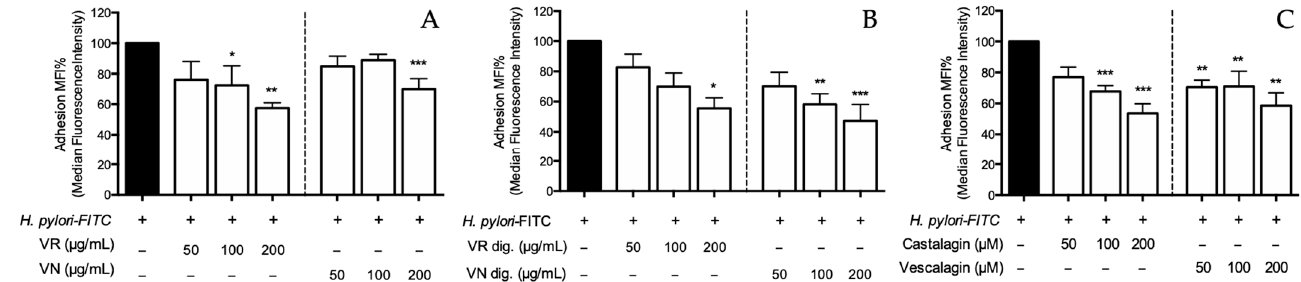
Figure 7. Effect of Castanea sativa Mill. leaf extracts and pure ellagitannins on H. pylori adhesion. GES-1 cells were treated for 1 h with H. pylori -FITC (ratio 50:1, bacteria/cell), in addition to leaf extracts before ( A ) and after ( B ) in vitro simulated digestion, or ellagitannins ( C ). The bacterial adhesion to GES-1 cells was measured as fluorescence intensity using a cytofluorimeter. Results re expressed as the mean ± SEM ( n = 3) of the relative percentage in comparison to H. pylori infection (black bar), to which the value of 100% was arbitrarily assigned. * p < 0.05, ** p < 0.01, and *** p < 0.001 vs. H. pylori . MFI%, median fluorescence intensity; FITC, fluorescein isothiocyanate; VR, Castanea sativa Mill. var. verdesa leaf extract; VN, Castanea sativa Mill. var. venegon leaf extract; dig., in vitro simulated digestion.